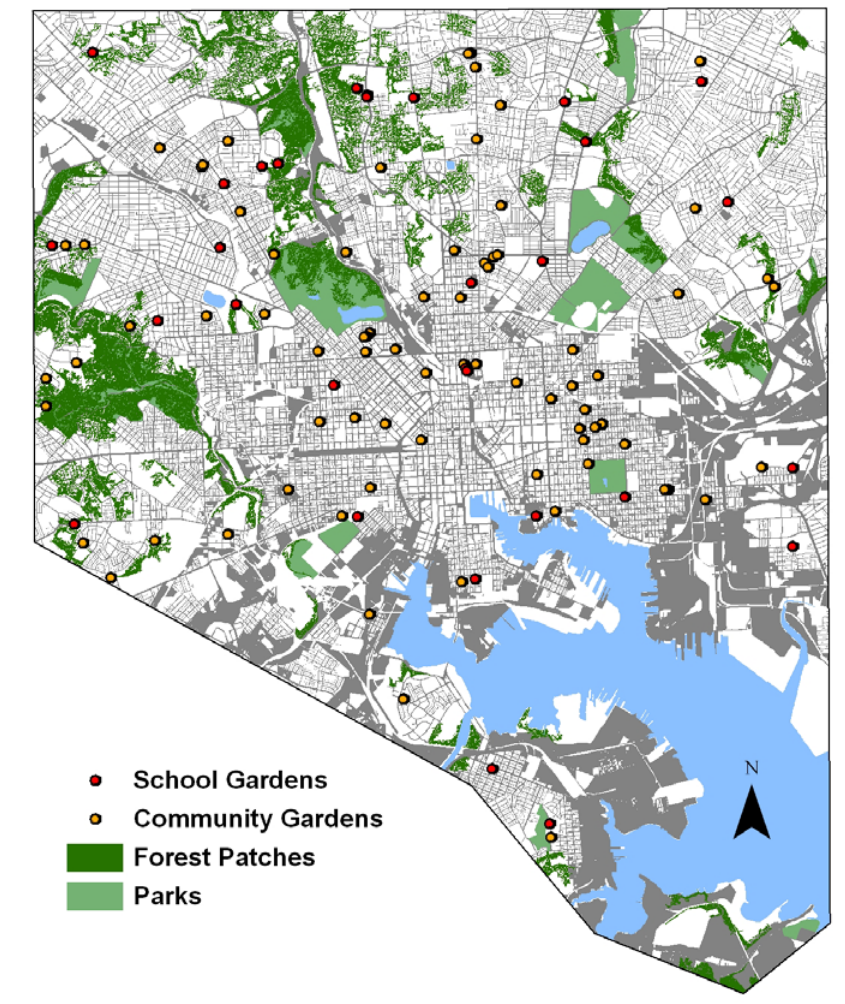
Figure 4. Map of 2010-2011 CGRN Community and Schoolyard Garden Sites, displaying locations of affiliated community and schoolyard gardens in Baltimore City. As the map indicates, these garden sites are distributed geographically throughout the